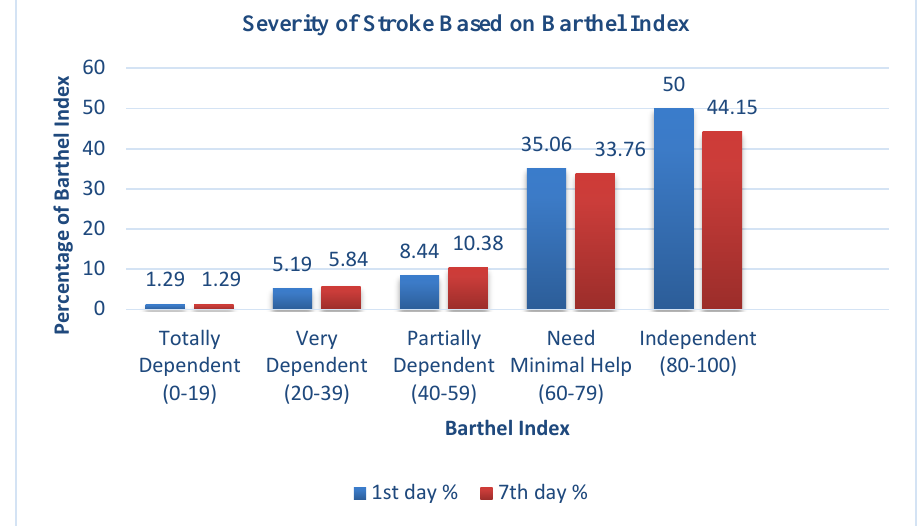
Fig. 6. Severity of stroke based on Barthel index with